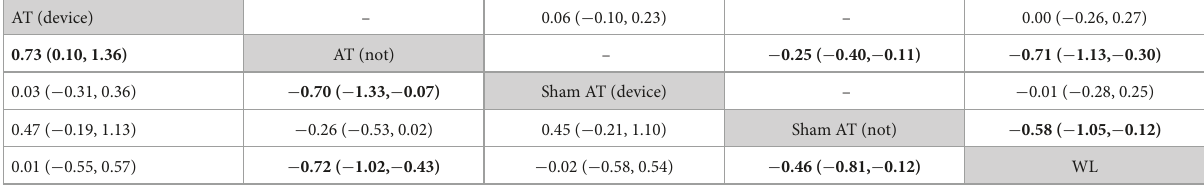
TABLE 3 League table for pairwise meta-analysis (upper right) and network meta-analysis (lower left): physical function. AT